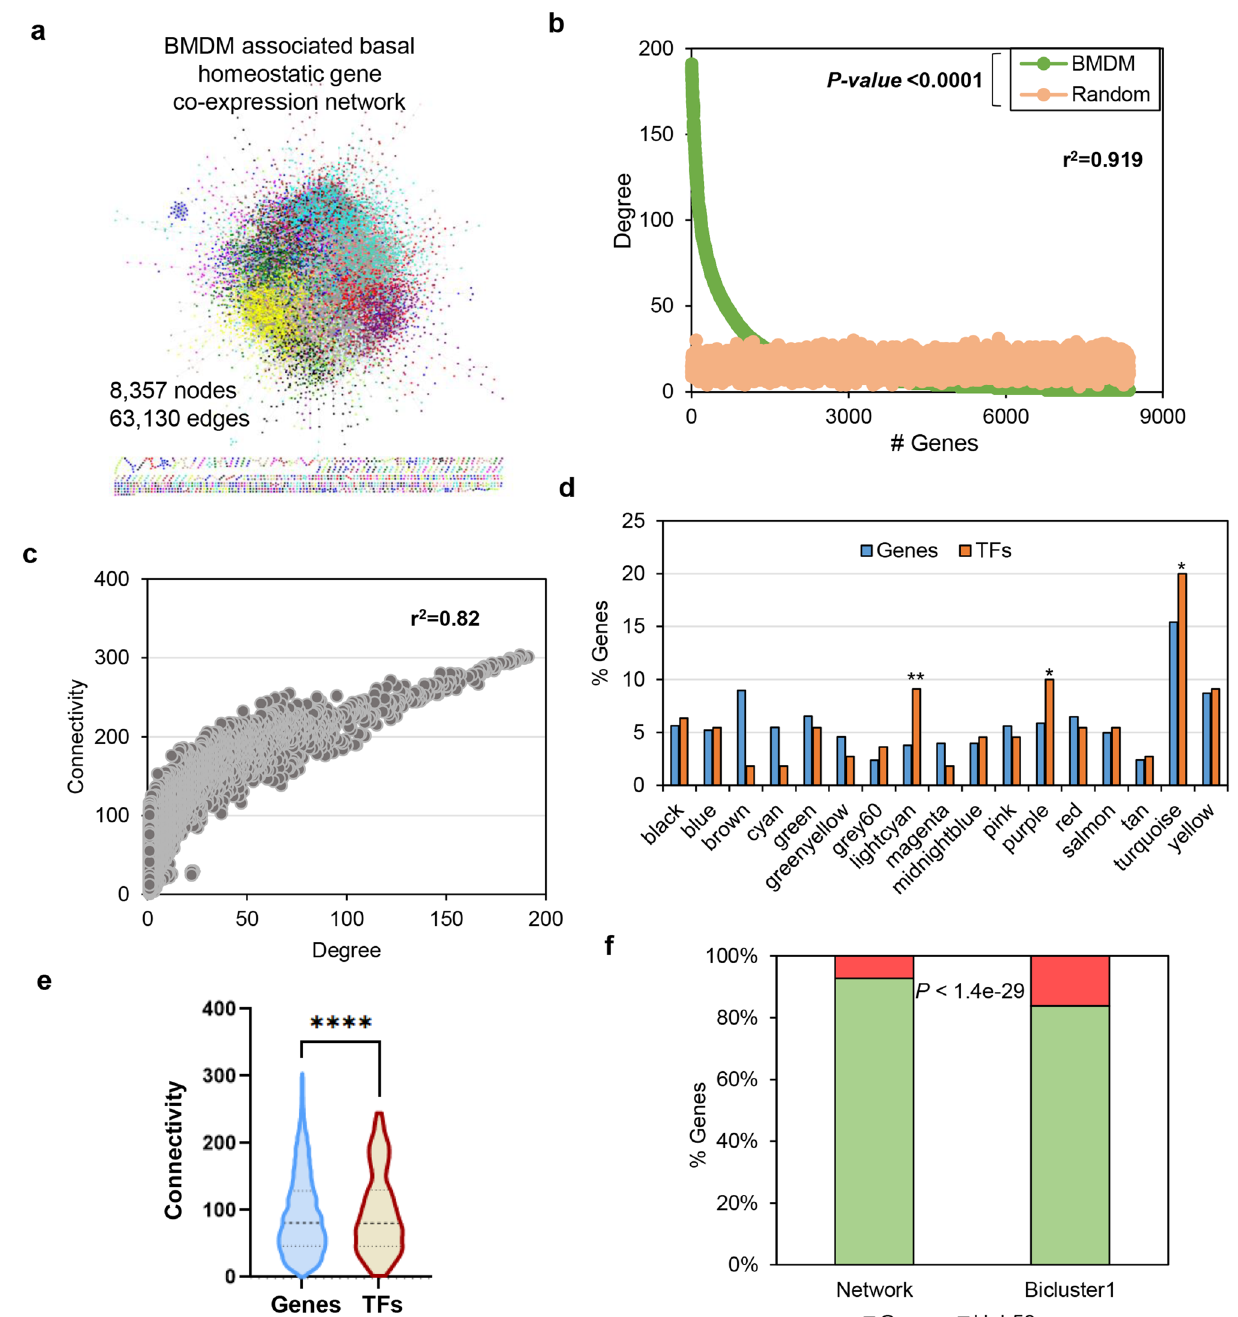
Figure 3. Transcription factors (TFs) and immunity genes are enriched in the co-expression network of unstimulated macrophage. ( a ) BMDM associated basal homeostatic gene co-expression network (8357 nodes and 63,130 edges) with 17 significant modules. ( b ) The degree distribution of nodes in BMDM associated homeostatic gene co-expression network ( r 2 = 0.92, Mann Whitney test P < 0.0001) and random network. Only 7.86% (657) of nodes have a high degree (Hub 50 ) representing the scale-free property of the co-expression network. ( c ) The relationship between connectivity and degree of nodes shows a significant positive correlation (r 2 = 0.82) suggesting the Hub 50 nodes and their modules are highly connected. ( d ) The distribution of genes and TFs (in percent) in represented modules with turquoise having a maximum 1205 (15.4%) genes and 22 TFs (20%, Hypergeometric enrichment test P < 0.05), and grey60 having minimum 186 genes (2.3%) and 4 TFs (3.63%) of all co-expressed genes/TFs. Also, TFs in purple and lightcyan modules are significantly enriched than genes assigned these modules (Hypergeometric test P < 0.01 and 0.05, respectively). ( e ) The average connectivity of all TFs is significantly higher (96.09) than the genes (93.02) in the co-expression network (Wilcoxon matched-pairs signed rank test P -value < 0.0001). ( f ) Immune-related genes form bicluster1 (Fig. 1e) are significantly enriched in Hub 50 (Hypergeometric enrichment test, P < 1.4e−29) representing their importance in the co-expression